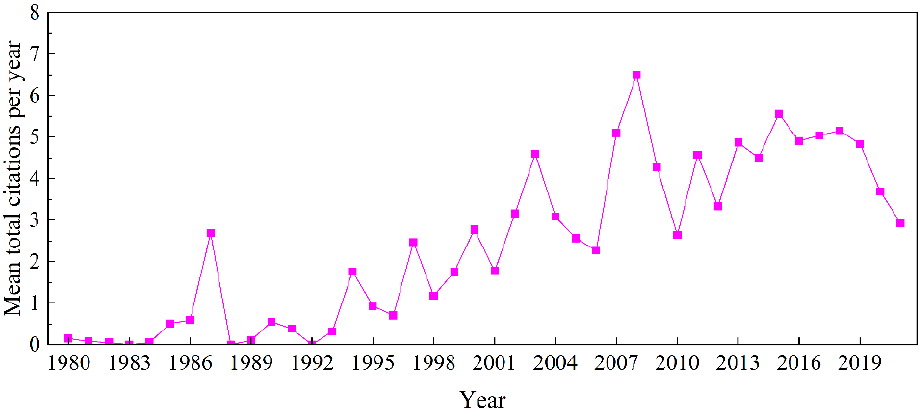
Figure 3. Mean total citations per year on farmland abandonment from 1980 to 2021.